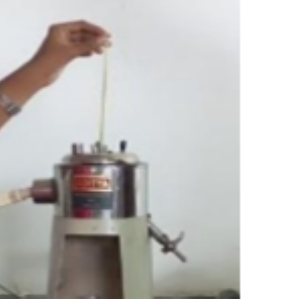
Figure 3. Experimentations of flash and fire point. Table 1. Plastic oil’s flash and fire points. Sr.